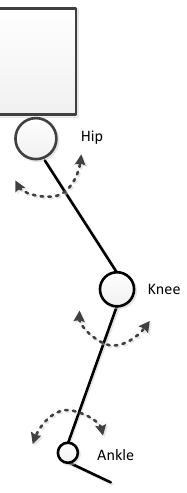
Figure 3. The dominant movements of the human walking gait.